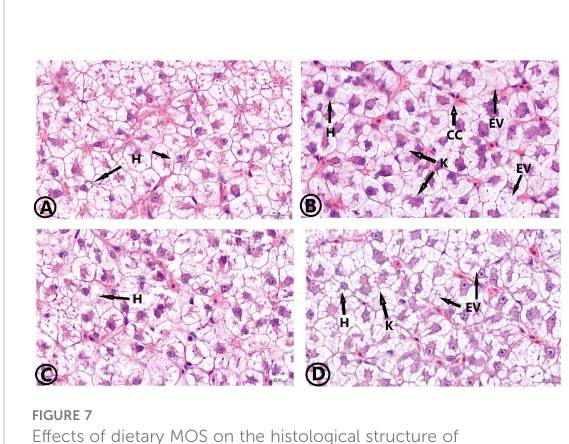
FIGURE 7 Effects of dietary MOS on the histological structure of hepatopancreas of the common carp under ammonia stress for 30 days. Stain H&E. Bar = 20 m m. 63.00X. Control group (A) , ammonia group (B) , MOS group (C) , and MOS/Am group (D) . H, Hepatocyte; K, Cell nuclear deviation; EV, Cell vacuolation; CC, In fl ammatory